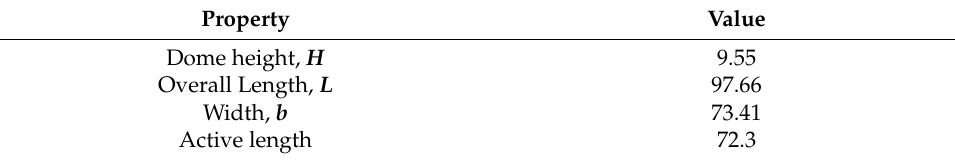
Table 2. Dimensions used for THUNDER (all properties are given in